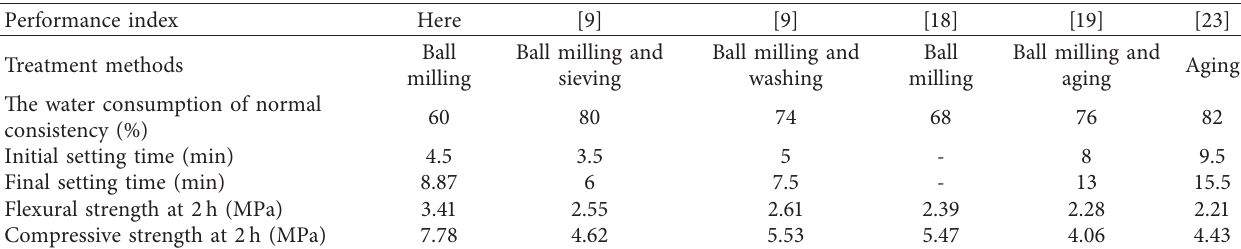
Table 3: Comparison of the effect of ball-milling treatment and other treatment methods.